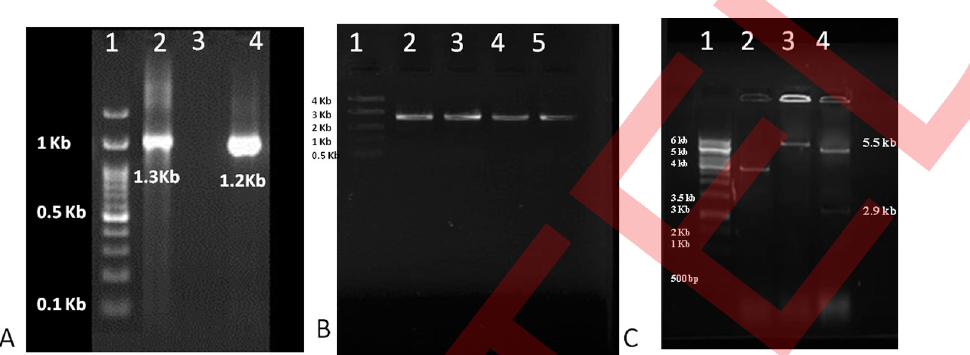
Fig 2. (A) Agarose gel electrophoresis of protease and chitinase gene amplicon. Lane 1 corresponds to ladder, and Lane 2 and 4 indicate the presence of the protease gene (1.3 kb) and chitinase gene (1.2 kb), respectively; (B) Lane 1 represents DNA ladder, lane 2 to 5 represents overlapping PCR product of 2.9 kb; (C) The pUC18miniTn7FusionX Clone confirmation, Lane1- ladder, Lane 2- Unknown, Lane 3- pUC18miniTn7FusionX linearised for cloning, Lane 4- pUC18 MiniTn7 FusionX digested with BamHI and KpnI showing the insert release of 2.9 kb.